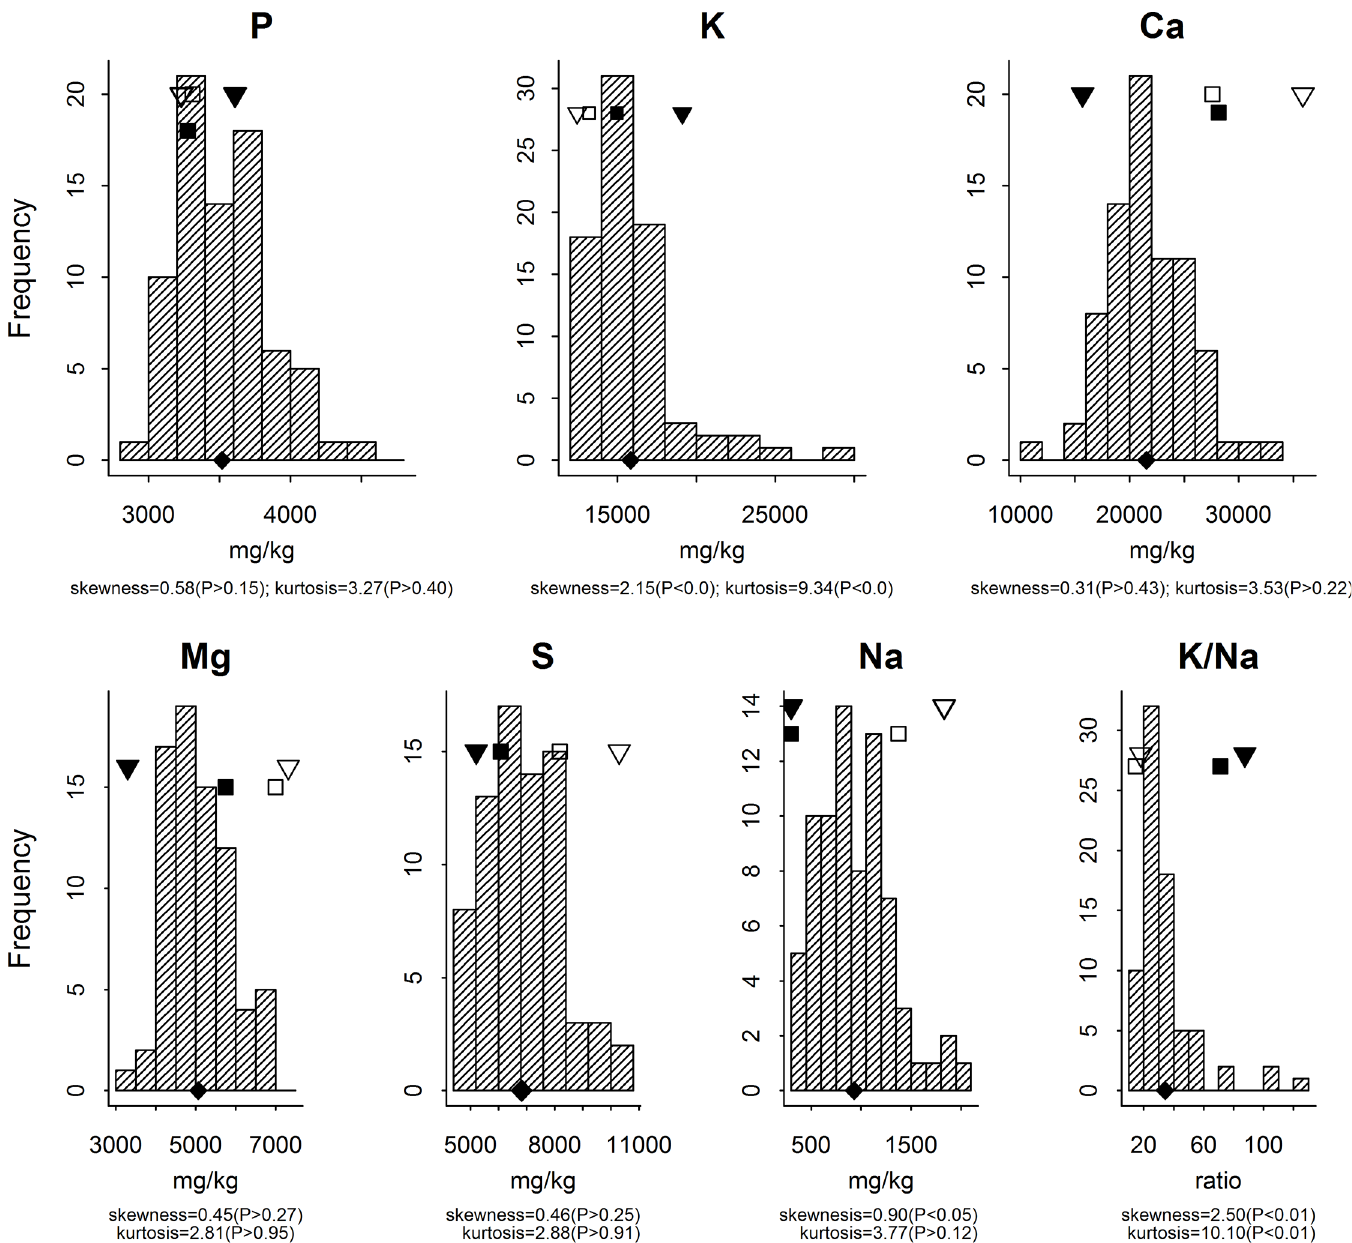
Fig 1. Distribution and normality tests of five macronutrient and Na concentrations and K/Na ratio in leaves of 77 RILs. ▼ = VH8; 5 = GUA; ∎ = Sipima 280, □ = Sicot 75; ◆ = population mean.